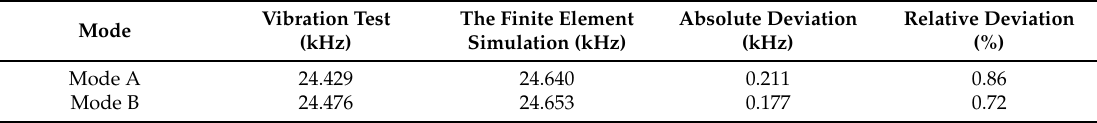
Figure 7. Mode A and B vibration modes and vibration velocity response spectra: ( a ) Mode A vibration mode and vibration velocity response spectrum (the side face of the horizontal transducer is the test surface); ( b ) Mode B vibration mode and vibration velocity response spectrum (the side face of the vertical transducer is the test surface). Table 4. Comparison between the finite element simulation and the prototype working frequency.